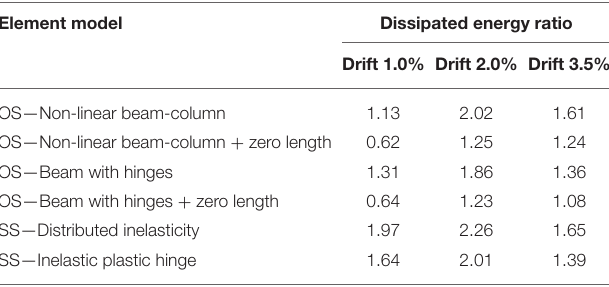
TABLE 4 | Experimental to numerical dissipated energy ratio for different drift levels of specimen